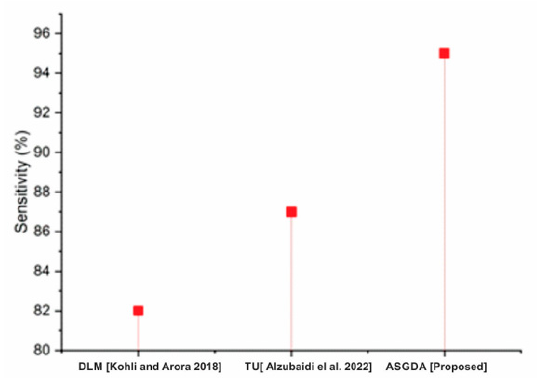
Figure 6. Sensitivity of proposed and existing work [40,41].